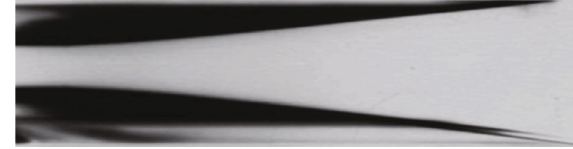
Figure 5: The wall-expanded negative in air medium.